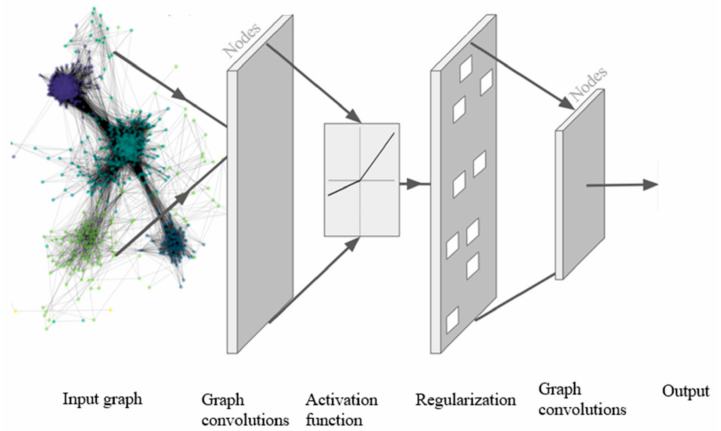
Figure 4. Graph Convolutional Networks [5].